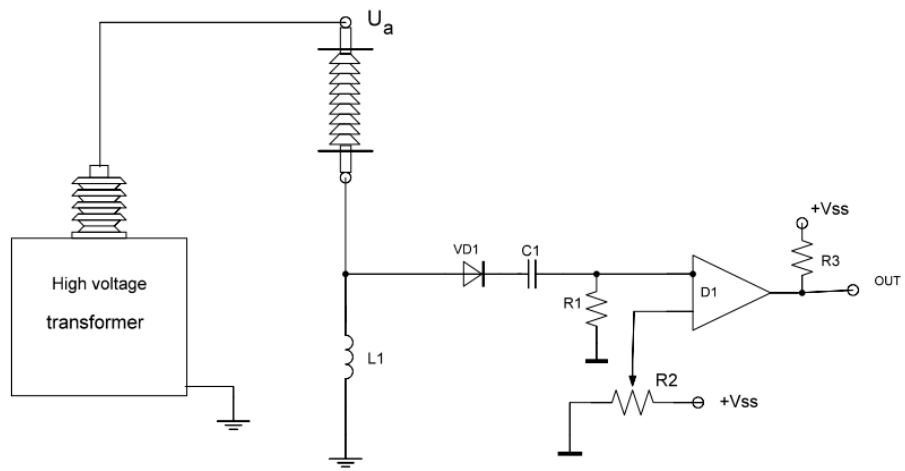
Figure 1. Diagram of the electrical contact sensor: U a — high voltage; +V ss — supply voltage.